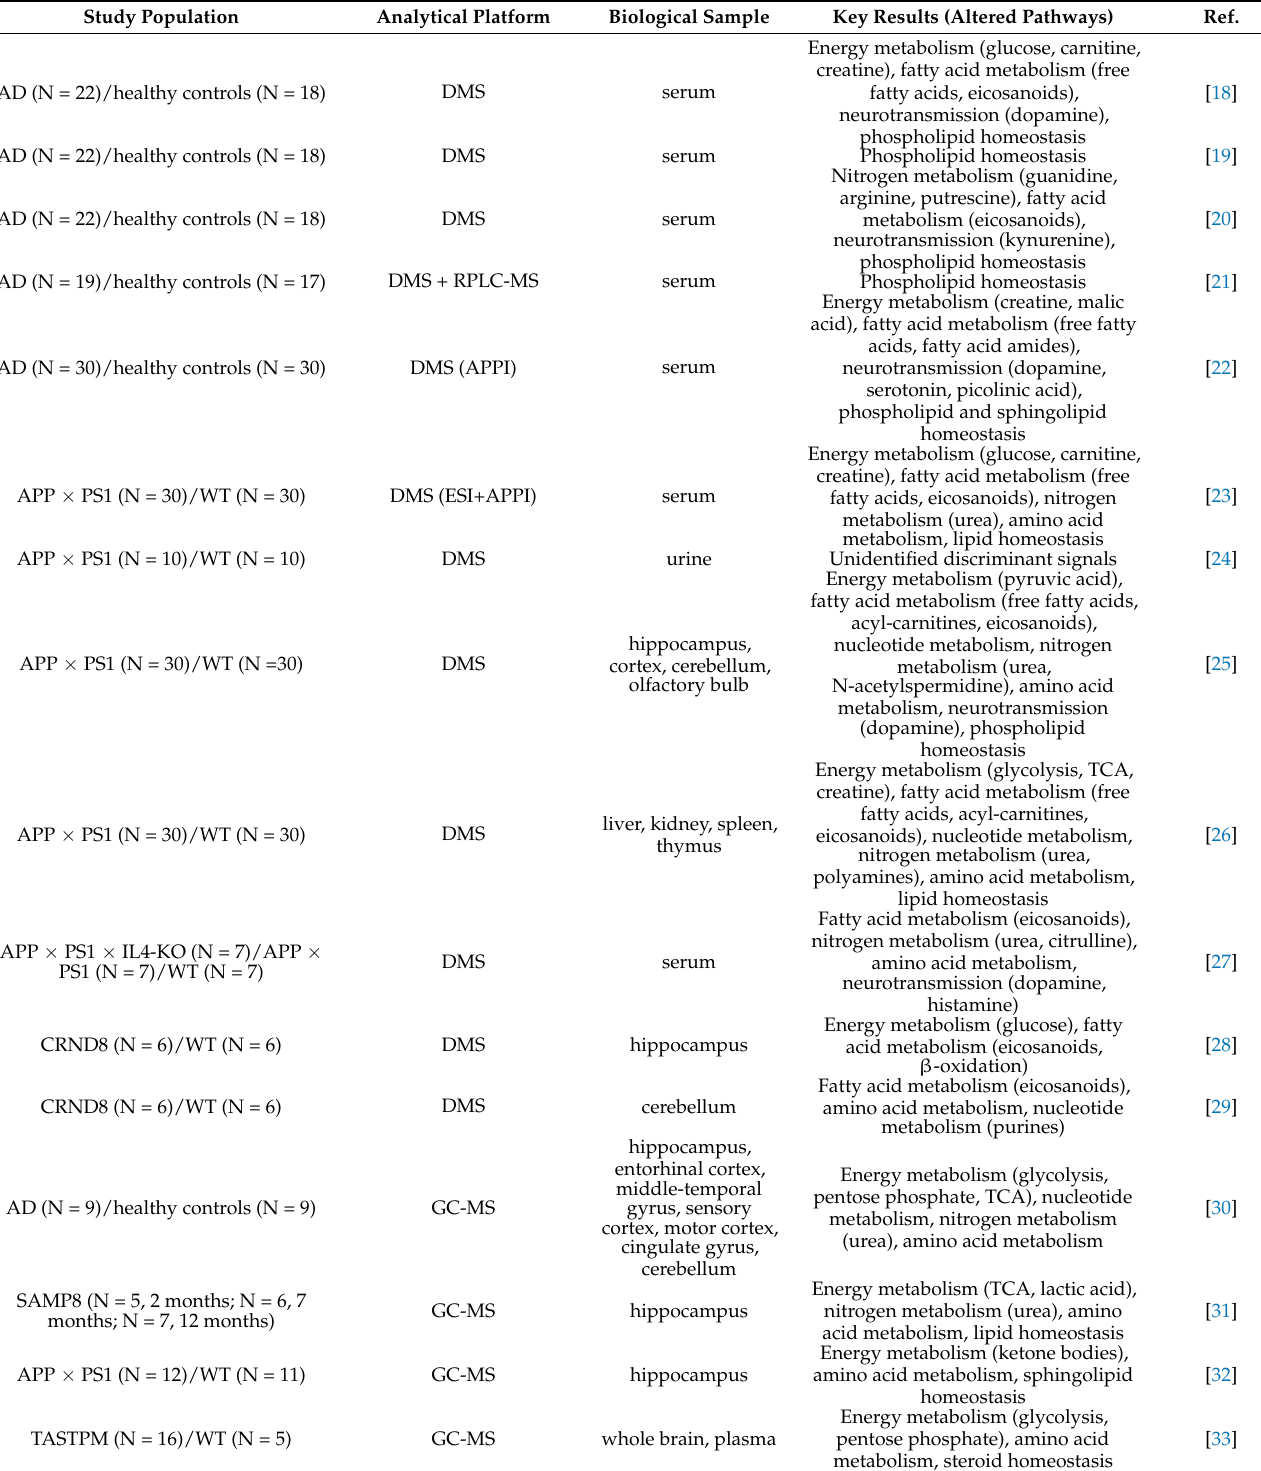
Table 1. Summary of hydrophilic-oriented metabolomics studies on Alzheimer’s disease. Study Population Analytical Platform Biological Sample Key Results (Altered Pathways)